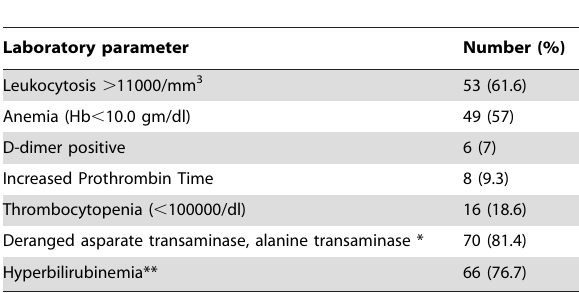
Table 5. Laboratory parameters of 86 patients at time